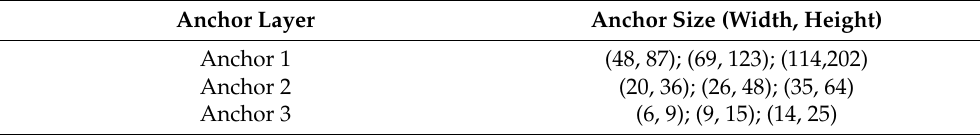
Table 2. The anchor mask setting parameters are derived from Figure 11.